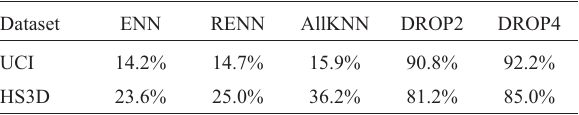
Table 2 - Datasets average reduction with a pre-processing parameter of k =